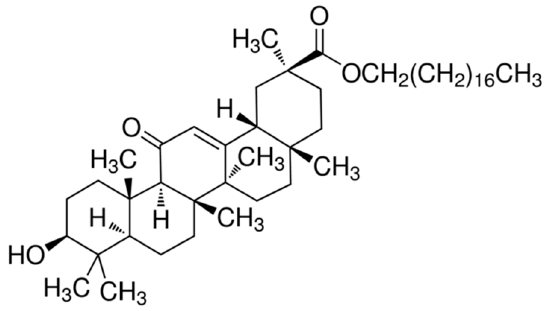
Figure 2. Chemical structure of SG.